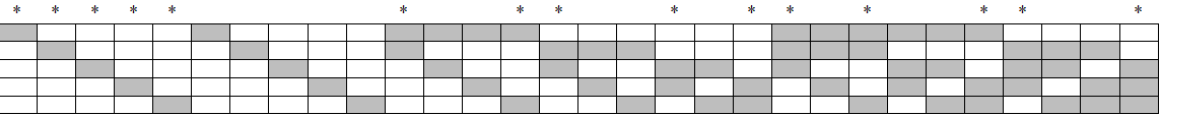
Figure 1. K -by- I Q’ matrix for simulation Study 1. Note: blank means ‘0,’ and gray means ‘1’; ‘*’ denotes items used in the I = 15 conditions.